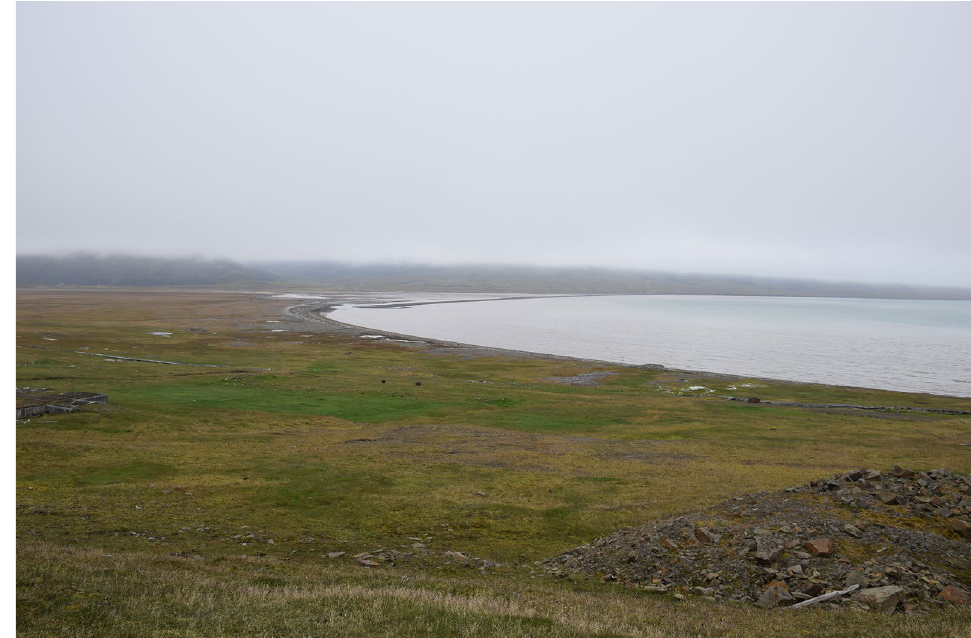
Figure 4. The general view of the Colesdalen study site. Vegetation and microforms in Colesdalen are similar to those of the Bjørndalen and Bolterdalen. In the front and at the back of the image non-vegetated mineral disturbance surfaces can be seen.